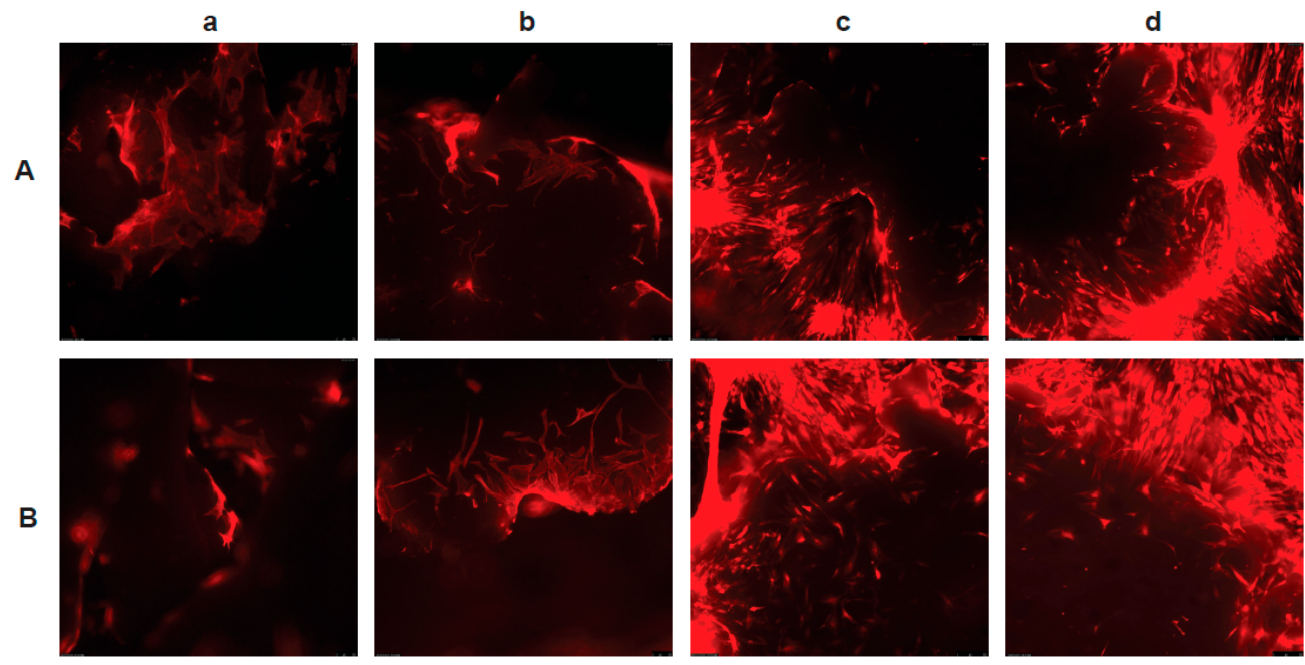
Figure 3. Adhesion and proliferation of hADMSCs. Red fluorescent protein-transduced human ADMSCs adhering, proliferating, and clustering on discrete areas on ( A ) the scaffold of 50:50 and 65:35 poly (lactic-co-glycolic acid) (50:65 PLGA) with 0.05 wt% low-oxygen graphene (LOG) and ( B ) the scaffold of 50:50 and 75:25 poly (lactic-co-glycolic acid) (50:75 PLGA) with 0.05 wt% low-oxygen graphene (LOG) on day 1 ( a ), day 7 ( b ), day 14 ( c ), and day 21 ( d ) post-seeding. On day 1, adherence was noted, followed by proliferation (indicated by an increase in cell density) and cell-to-cell communication (indicated by cell clustering) on days 7, 14, and 21.